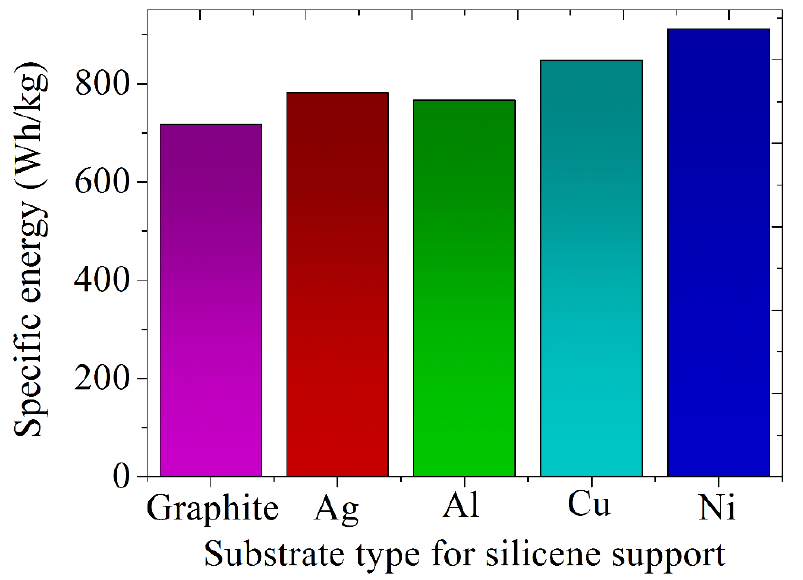
Figure 10. Estimated specific energies of batteries with a silicene anode placed on various types of substrates -. Reprinted with permission from Ref. [63]. 2022, Ural Federal University&Institute of High Temperature Electrochemistry, UB RAS.